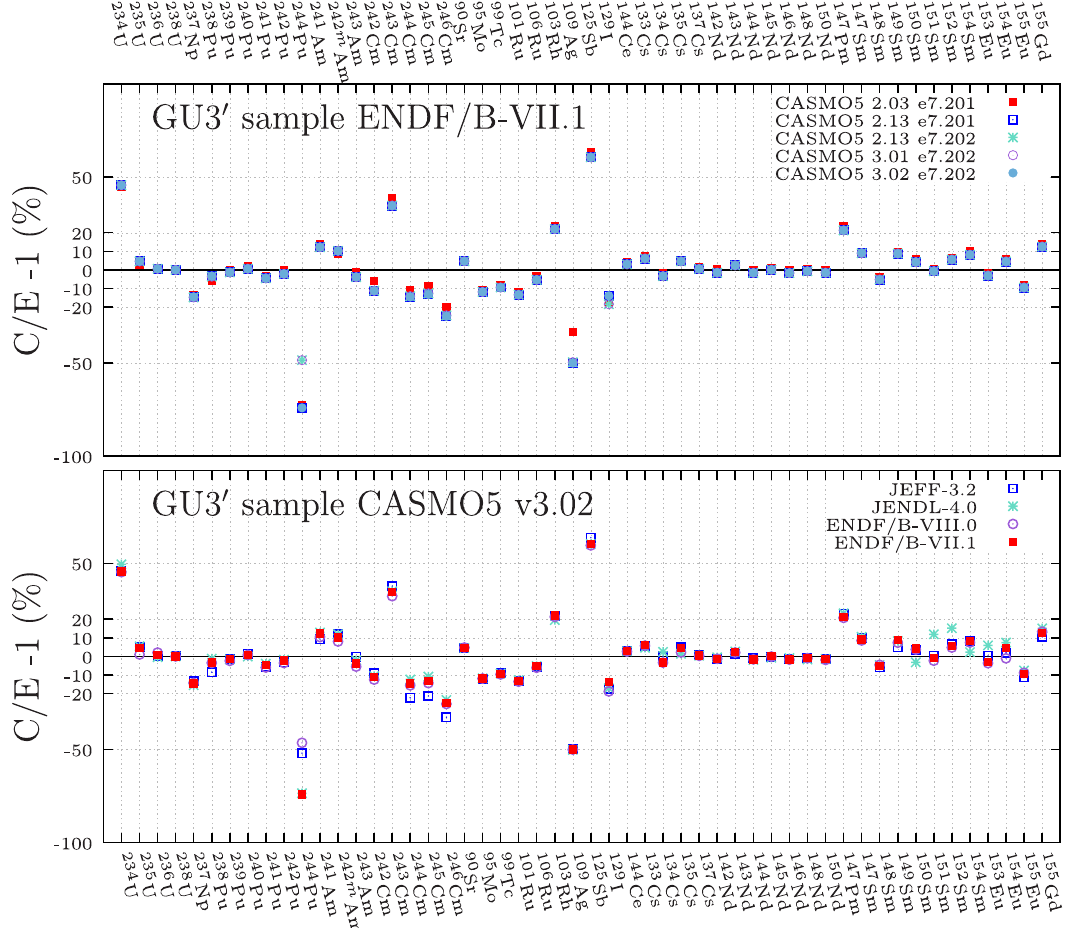
Fig. 4. Comparisons between calculated and measured values from SCK.CEN (C/E-1) for each measured isotopes from different calculations for the GU3’ sample; top: various CASMO5 versions with the ENDF/B-VII.1 library, bottom: same CASMO5 version for four different